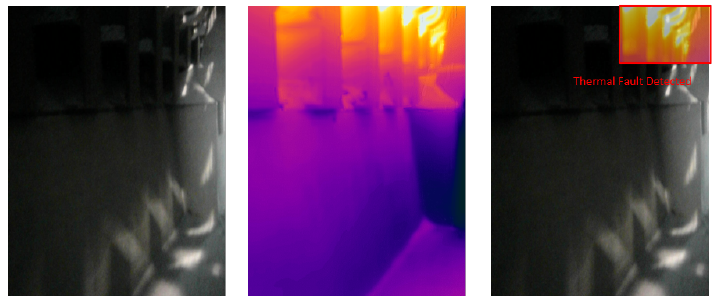
Figure 27. Thermal anomalies detection on-site for test run 5.